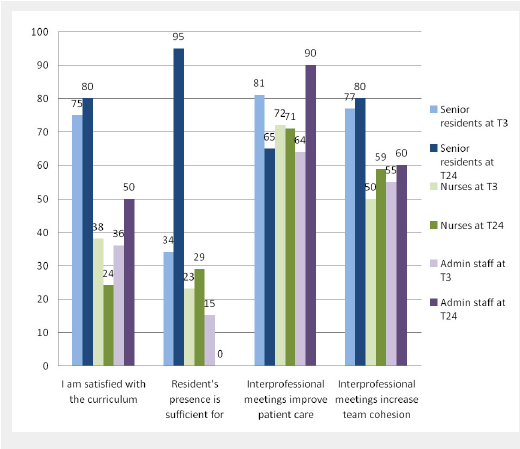
Evaluation of the new curriculum at 3 (T3) and 24 months (T24) by senior residents, nurses and administrative staff (expressed in %). Response rates: senior residents: n = 19 (43%) at T3 and n = 20 (44%) at T24; nurses: n = 28 (47%) at T3 and n = 17 (27%) at T24, administrative staff: n = 26 (87%) at T3 and n = 10 (50%) at T24.